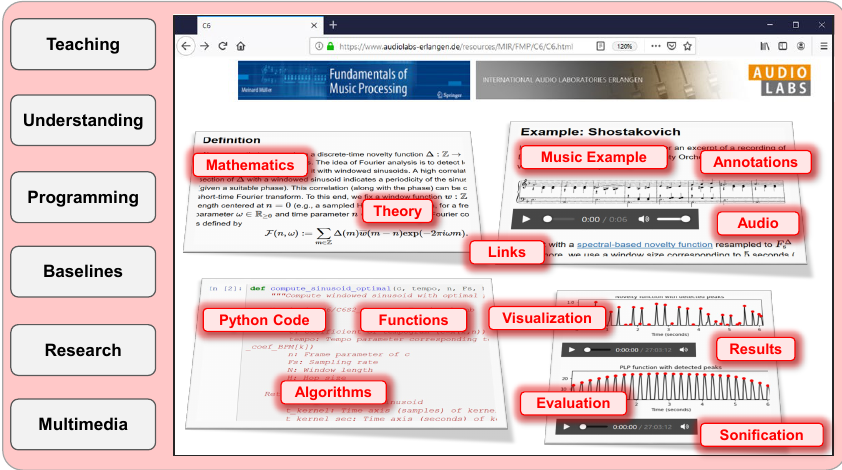
Figure 1. Components and educational aspects of the FMP